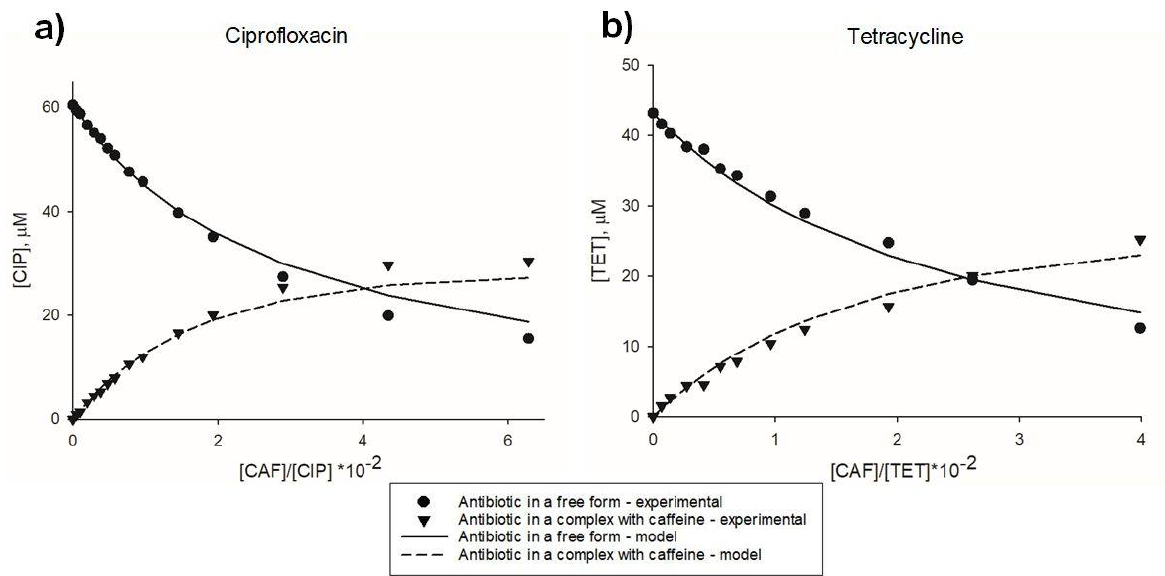
Figure 3. Comparison of experimental and theoretical concentrations in antibiotic-xanthine mixtures analyzed spectrophotometrically. ( a ), ciprofloxacin-caffeine interactions; ( b ), tetracycline-caffeine interactions. Points represent concentrations of antibiotic in a free form (circles) and in a complex with caffeine (triangles), calculated with two-component spectra decomposition. Lines represent concentrations of an antibiotic in a free form (solid line) and in a complex with caffeine (dashed line), calculated using statistical-thermodynamical model of mixed aggregation [32] (with K AC ± standard error values 24.71 M − 1 ± 0.89 M − 1 for ciprofloxacin-caffeine interaction and 45.6 M − 1 ± 2.5 M − 1 for tetracycline-caffeine interaction). CAF, caffeine, CIP, ciprofloxacin. TET, tetracycline .